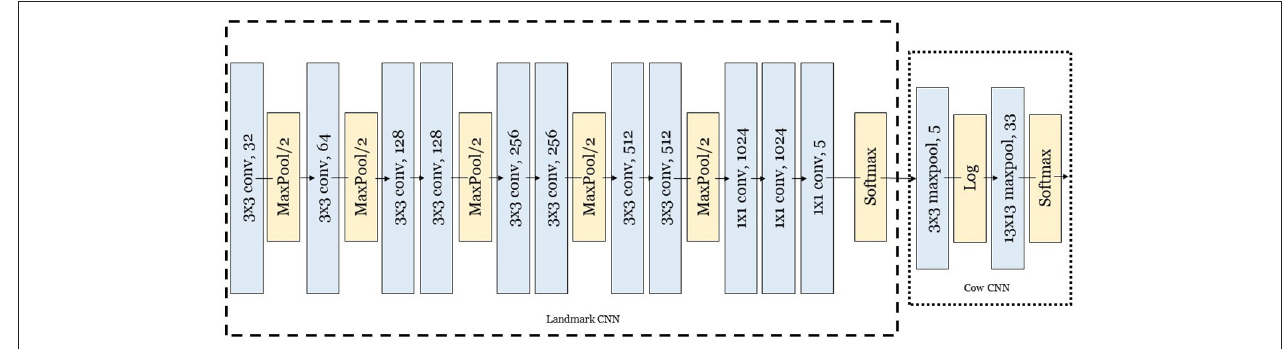
FIGURE 4 | The architecture of the 2-step CNN cow detector. First CNN is used for landmark detection and the second one is used for actual cow detection (object and its orientation). The input for the first Landmark CNN is an image of any size [RGB channels scaled to the range (Rutten et al., 2013; Porto et al., 2015)]. The output of the Landmark CNN is a five-channel probability map which contains five different landmark classes: background, cow front middle, cow center, cow back middle and cow head. This five-channel probability map serves as the input for Cow CNN, resulting in another probability map as output. The output from the Cow CNN segments the original input image into either background or an object (cow) with known